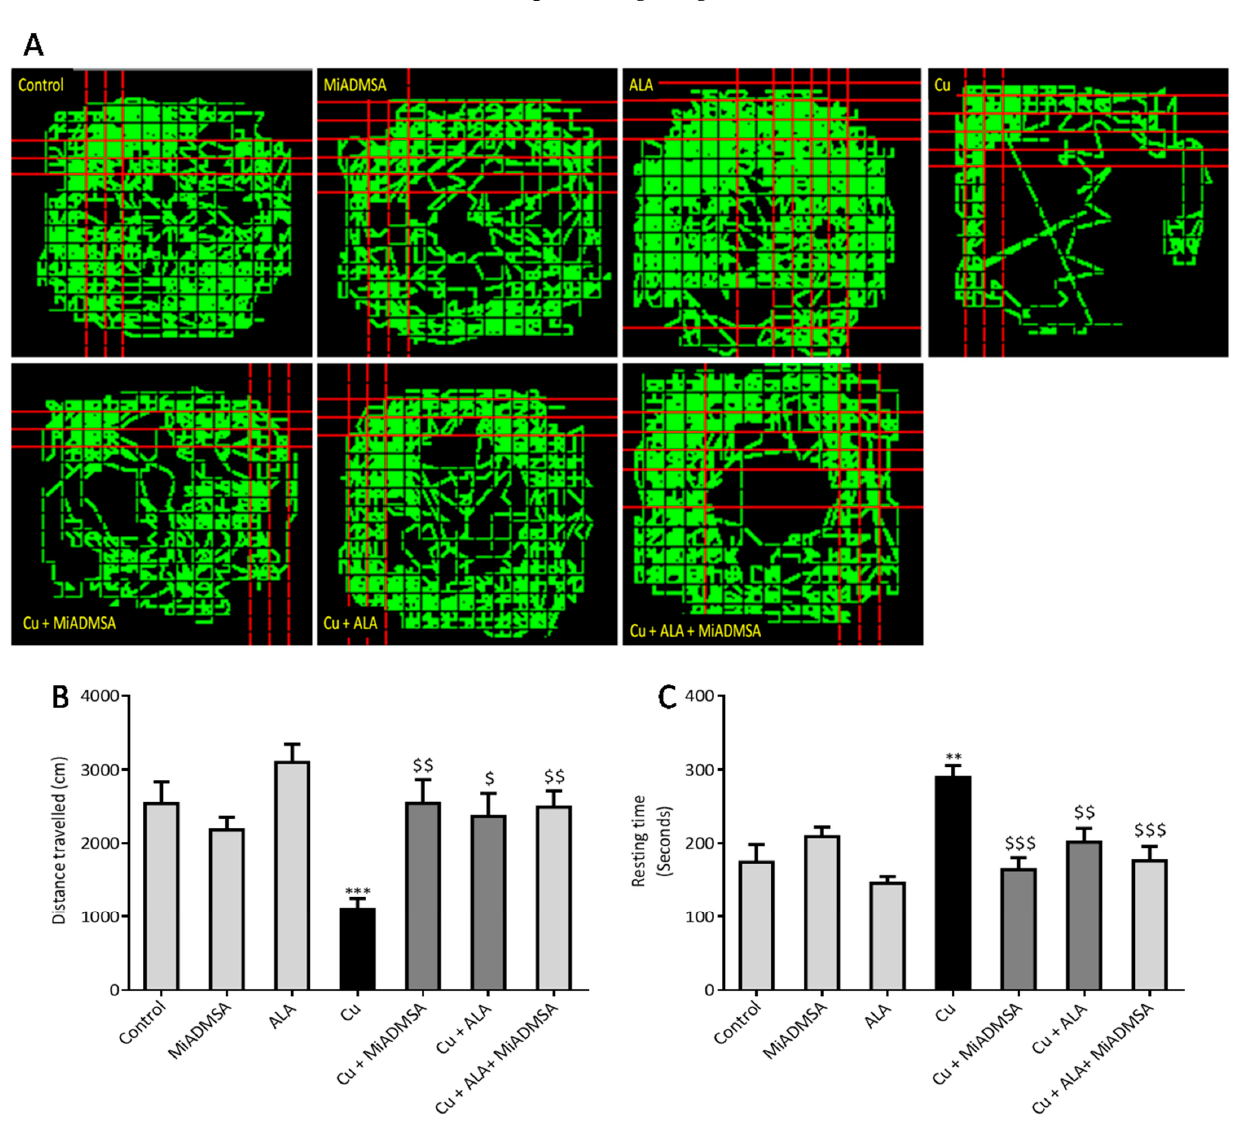
Figure 8. The MiADMSA and ALA combination therapy attenuated spontaneous locomotor activities. ( A ) Tracking graphs; ( B ) Distance travelled; ( C ) Resting time. All the values are expressed as mean ± S.E.M. ( n = 6), *** p < 0.001 vs. control and $ p < 0.05, $$ p < 0.01, $$$ p < 0.001 vs. Cu. **: It indicates the comparison between the groups which we have mentioned in the figure legends.